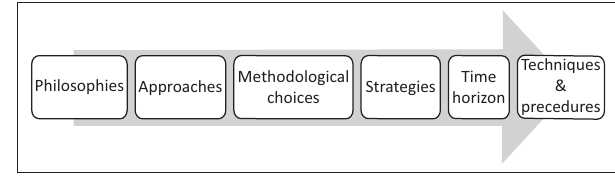
FIGURE 4: The research